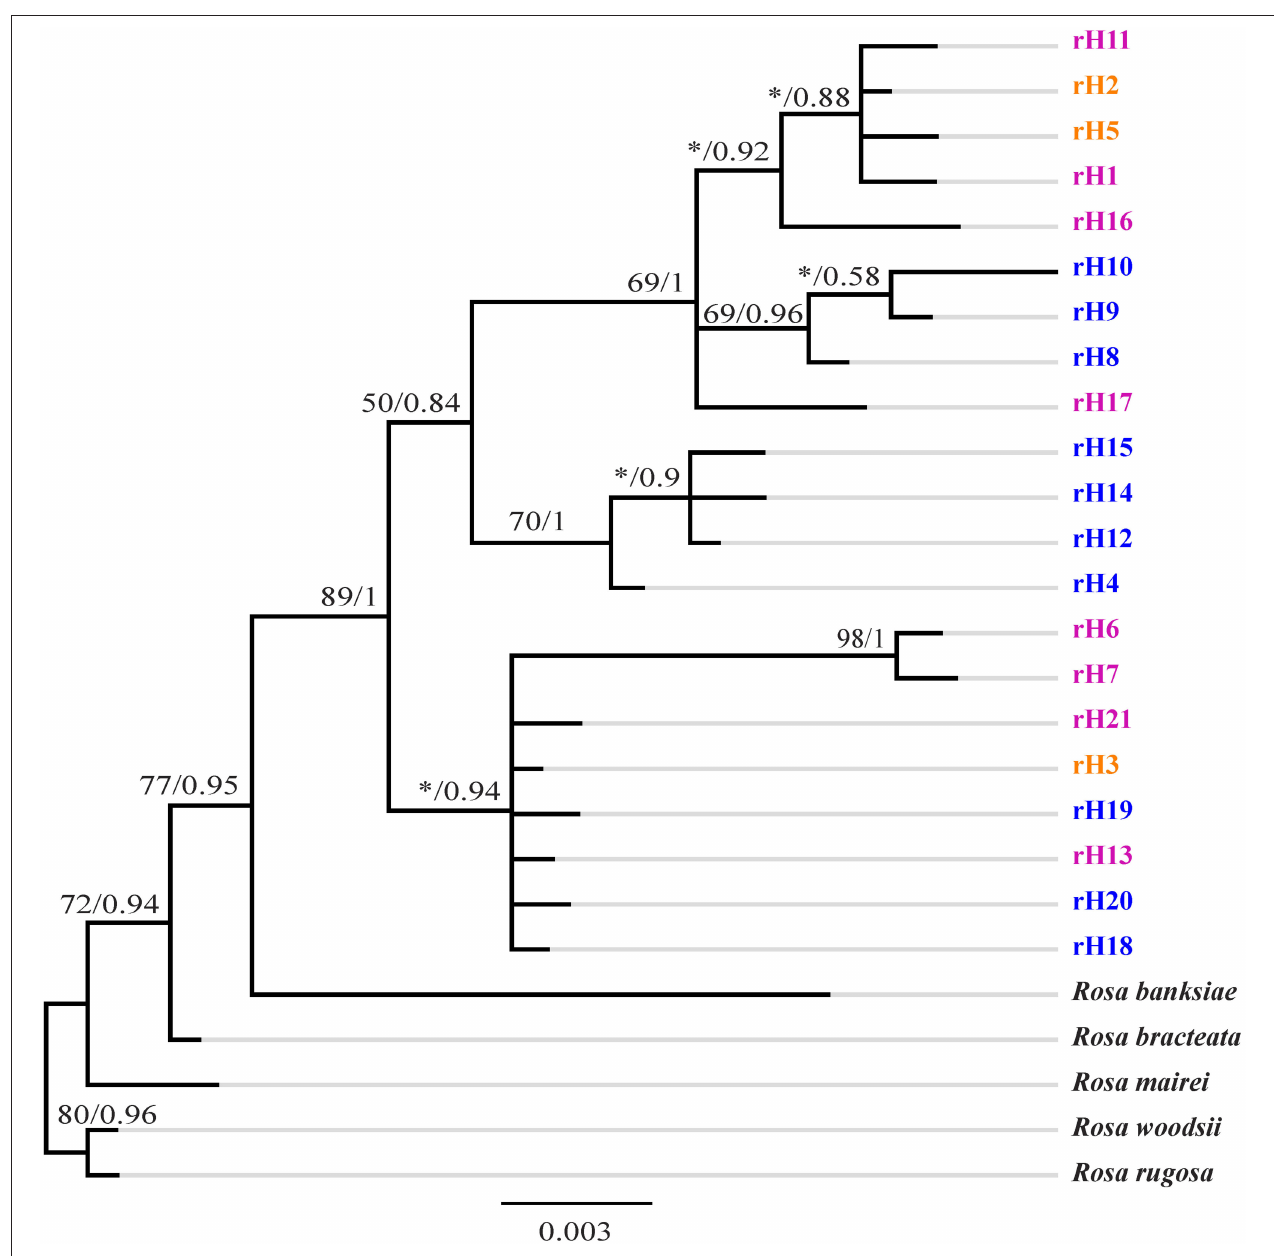
FIGURE 4 | Phylogenetic tree of ribotypes of R. chinensis var. spontanea and R. lucidissima complex. Bootstrap values (%) (ML) and the posterior probability values (BI) are indicated above the branches. R. lucidissima haplotypes are in pink, R. chinensis var. spontanea ones in blue, and the shared ones in orange. *Means the bootstrap value is less than